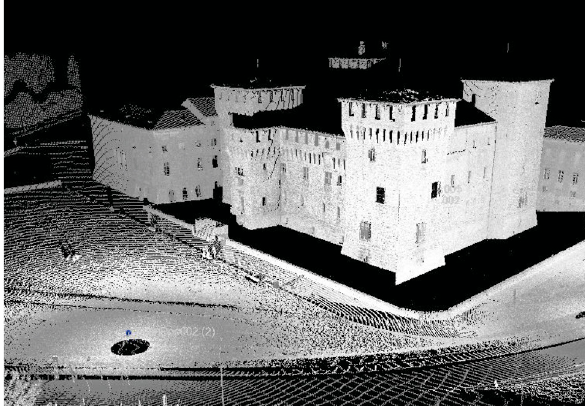
Figure 9. Point clouds of the external of the